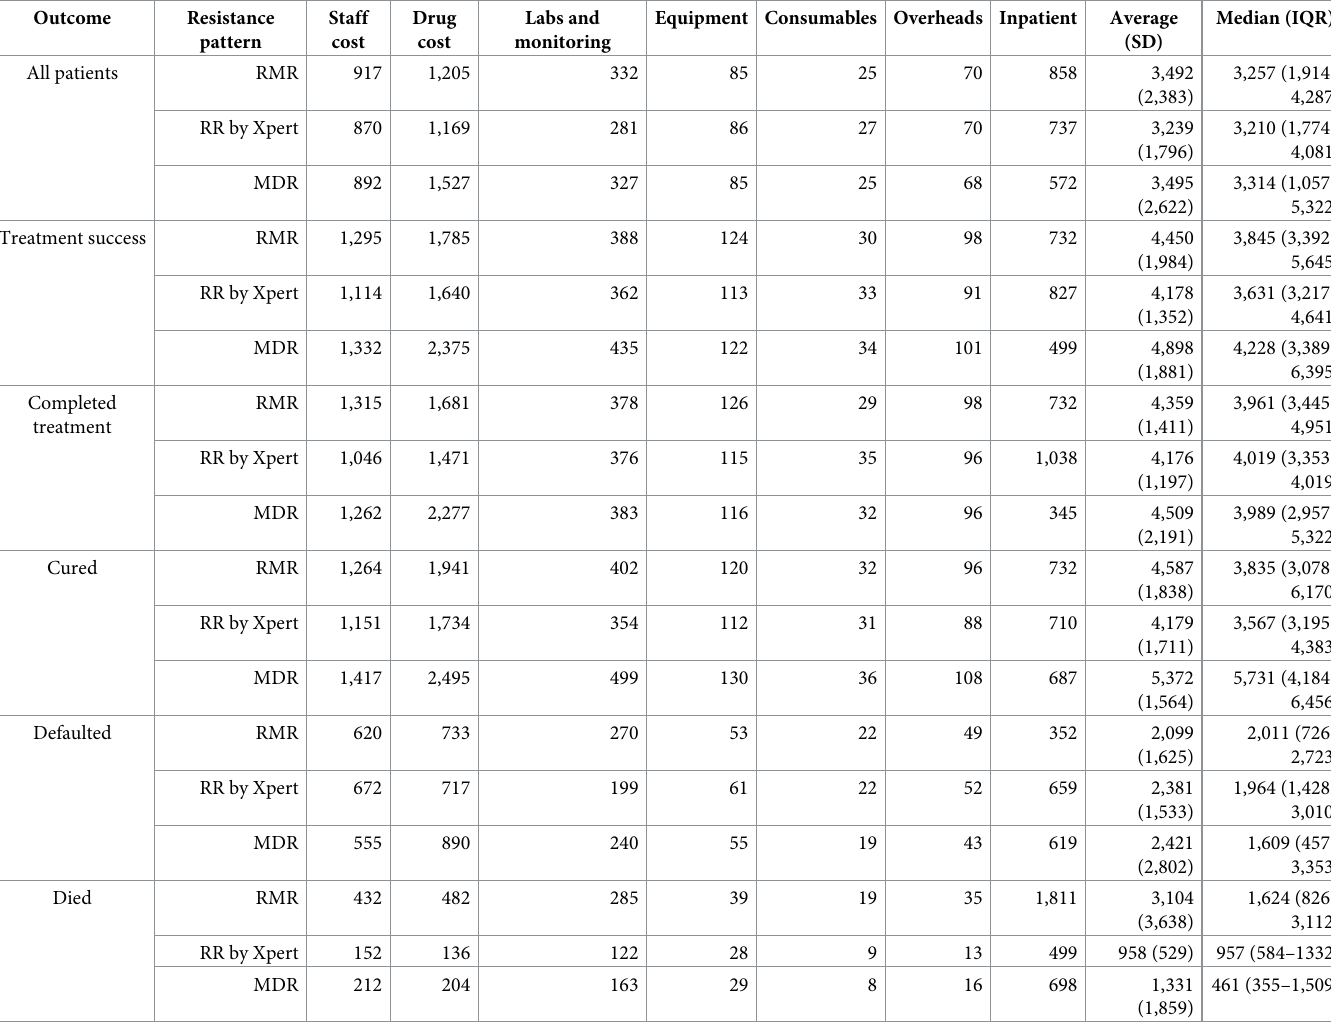
Table 3. Cost breakdown by outcome and TB resistance pattern (2017